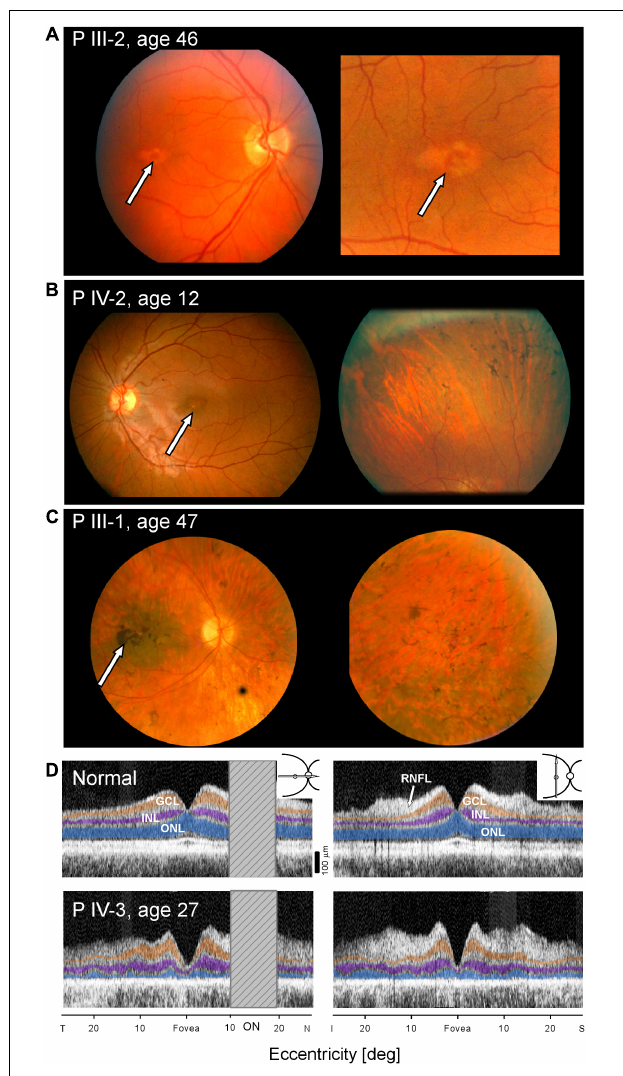
FIGURE 3 | Maculopathy at all stages of the IRD. (A–C) Fundus photographs of PIII-2, PIV-2, and PIII-1. Arrows point to maculopathy. (D) OCTs of normal subject (upper panels) compared with scans of PIV-3 (lower panels) along horizontal and vertical meridians (insets, upper right). Hatched bar shows the location of the optic nerve head in the horizontal scans. ONL, outer nuclear layer, highlighted in blue; INL, inner nuclear layer, purple; GCL, ganglion cell layer, orange; and RNFL, retinal nerve fiber layer, arrow. T, temporal; N, nasal; I, inferior, S, superior retina.